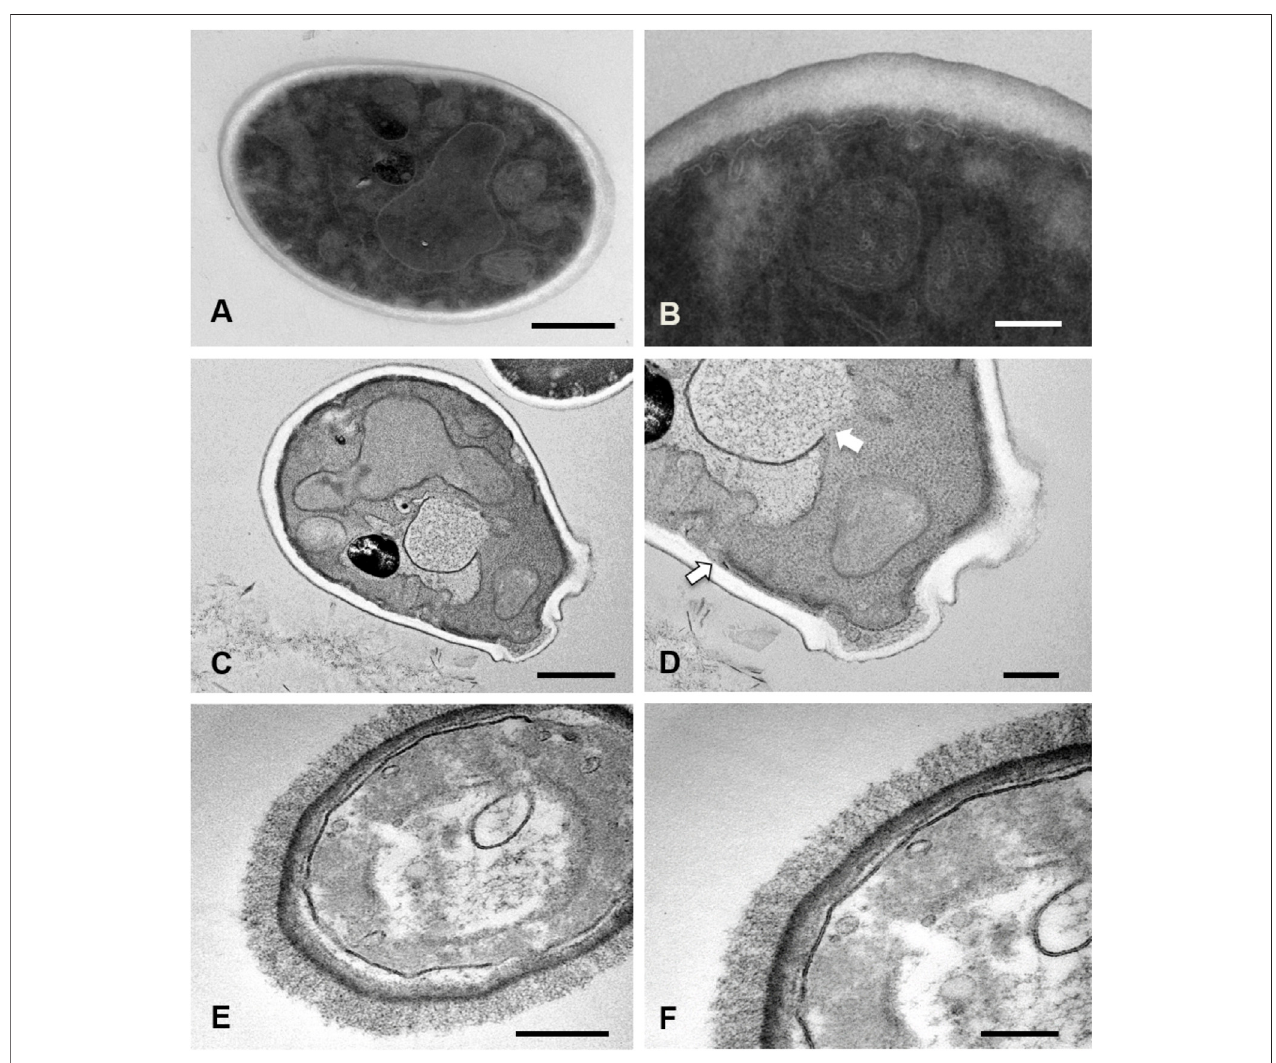
FIGURE 1 | Ultrastructural analysis of Sporothrix brasiliensis treated with silver nanocomposites. S. brasiliensis ATCC 5110 treated for 48 h with MIC 50 of nanocomposites were analyzed by TEM. Untreated yeasts exhibited an intact structure: compact cell wall, continuous cytoplasmic membrane and electrodense (A,B) . While yeasts exposed to AgNPs showed damage to the integrity of the membrane of cytoplasmic organelles and the cell membrane (white arrows) (C,D) . Cells treated with AgNPs@Chi exhibited membrane detachment and cell surface disaggregation (E,F) . Bars scale = 500 nm (A,C,E) and 200 nm (B,D,F) .